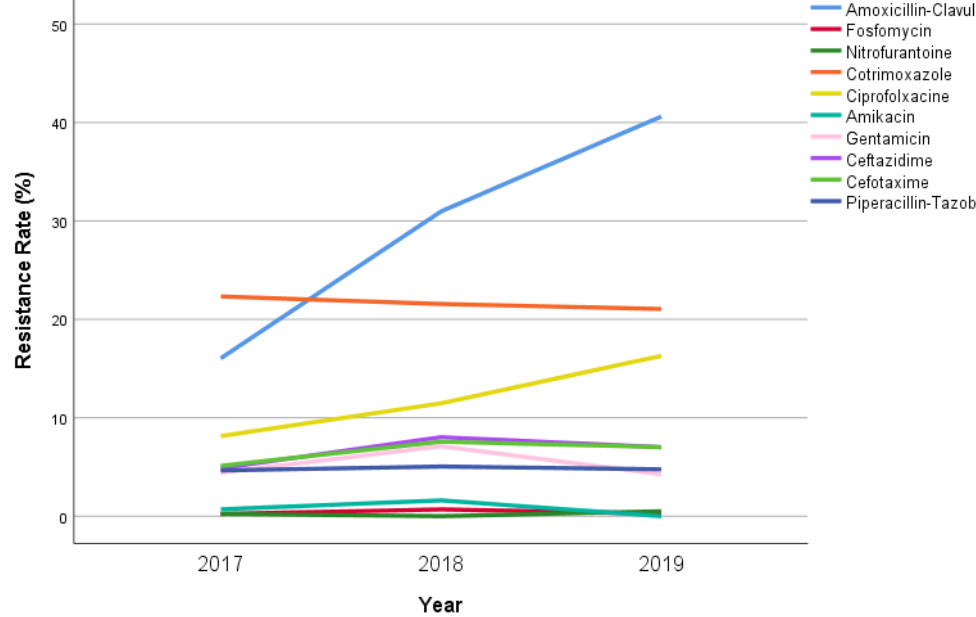
Figure 2. Annual antibiotic resistance rate (% of all isolates) of E. coli in our study population. Moreover, ESBL, MDR, and XDR strains were found in 64 (6.1%), 66 (6.3%), and 14 (1.3%) cases, respectively.